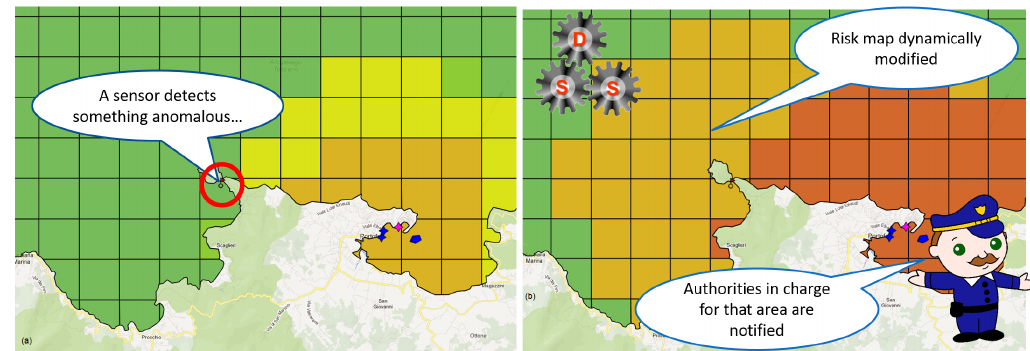
Figure 6. Example of the MIS interface operating: ( a ), the generating event detected from a sensor is processed and transmitted to the MIS; ( b ), the DSS generates a preliminary alert, the risk map is modified dynamically, and a warning is eventually sent to the responsible authorities. (dynamic risk map scale: each square is 1 km 2